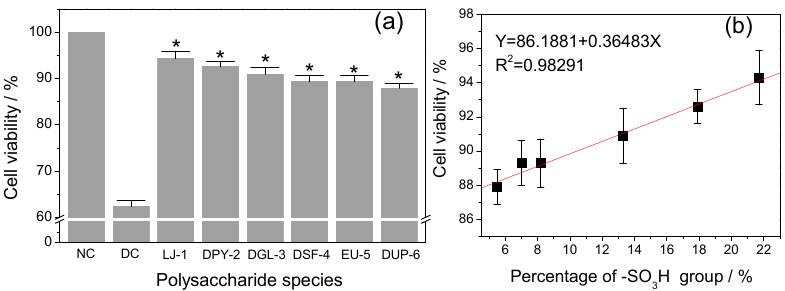
Figure 5. Repair capacity of six low-molecular-weight seaweed polysaccharides (SPSs) on oxalate-induced damaged HK-2 cells ( a ), and the relationship between –SO 3 H content and repair capacity of SPSs ( b ). Each bar is derived from three independent experiments and data are reported as Mean ± SD. Compared with damaged control group, * indicates p < 0.01. NC: Normal control; DC: Damaged control; LJ-1: Laminaria -1; DPY-2: degraded Porphyra -2; DGL-3: degraded Gracilaria -3; DSF-4: degraded Sargassum -4; EU-5: Eucheuma -5; DUP-6: degraded Undaria -6.